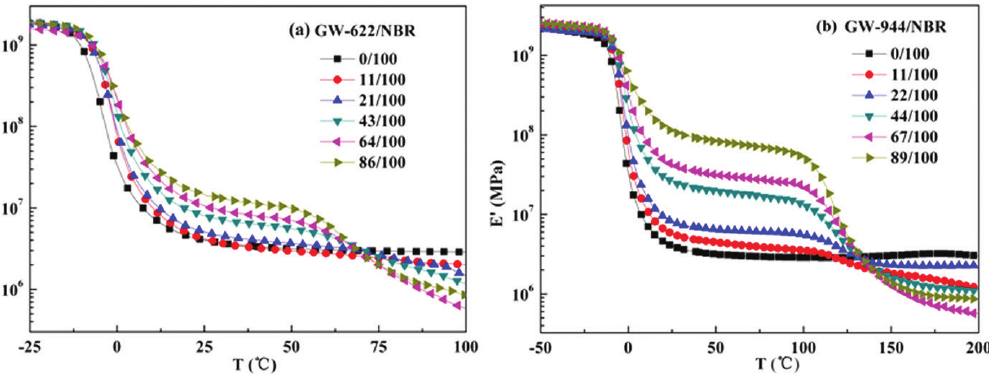
Figure 6: Temperature dependence of the storage modulus (E’) values of (a) GW-622/NBR composites and (b) GW-944/NBR